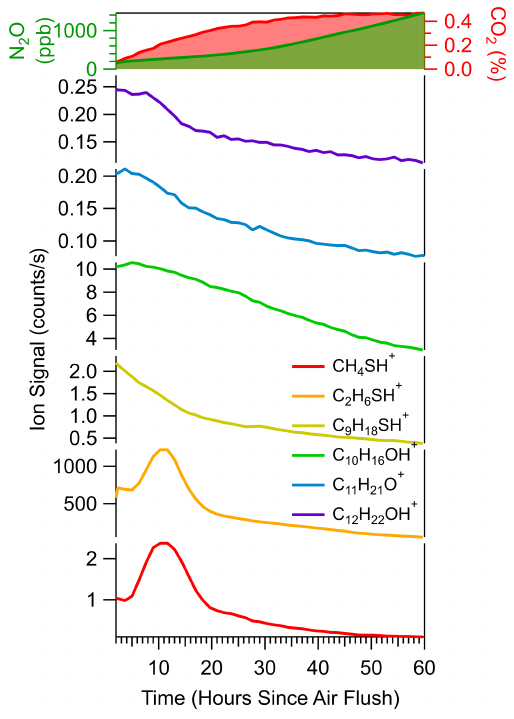
Figure 13. A sudden change from anoxic to oxic soil conditions, induced by flushing with UZA, drives dynamic responses in N 2 O, CO 2 , and a variety of VOCs captured using the diffusion-based soil probe integrated with the TILDAS and Vocus analyzers. Sys- tem 2 Experiment 6 with a Biosphere 2 Tropical Rainforest soil (Table